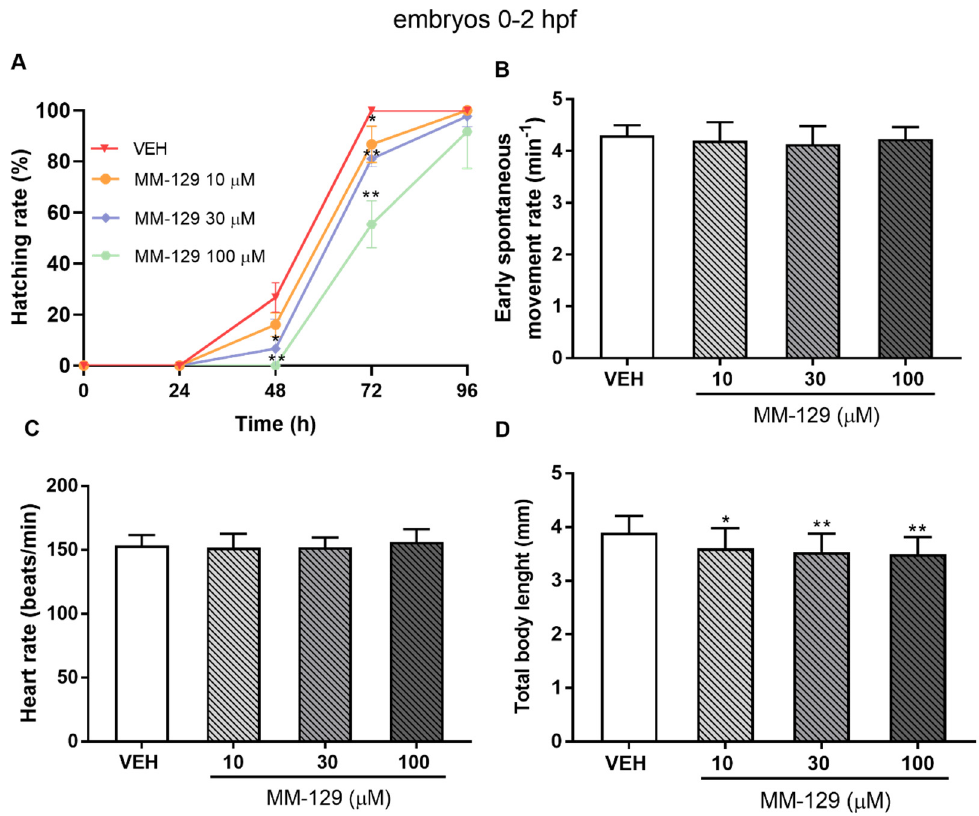
Figure 5. Hatching rate ( A ) for zebrafish embryos at 0–2 hpf exposed to MM-129 concentrations or vehicle (VEH) for 96 h; early spontaneous movement rate ( B ) for zebrafish embryos at 0–2 hpf exposed to MM-129 concentrations or VEH at 24 h of incubation; heart rate ( C ) and total body length ( D ) of zebrafish embryos 0-2 hpf at 96 h of incubation. Data are shown as mean ± SD; * p < 0.05; ** p < 0.01; vs. VEH within the group, n = 60 for each concentration. Abbreviations: MM-129—pyrazolo[4,3-e]tetrazolo[4,5-b][1,2,4]triazine sulfonamide; VEH—vehicle; hpf—hour post–fertilization.